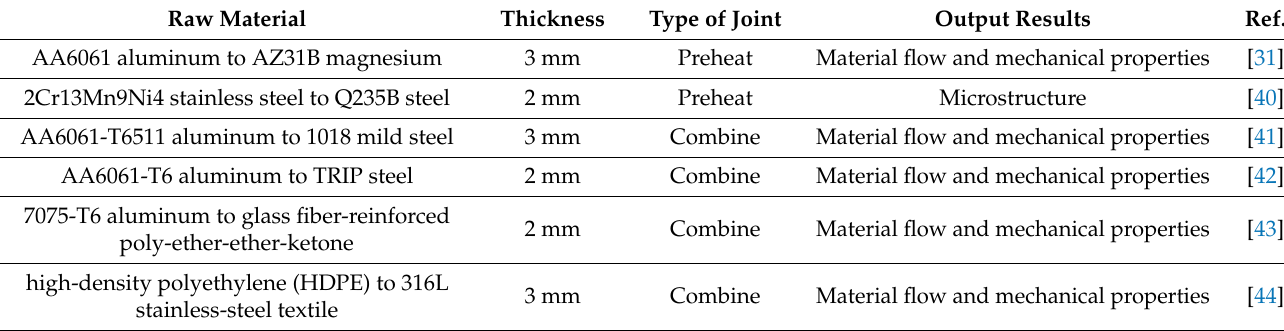
Table 4. Dissimilar joints welded by